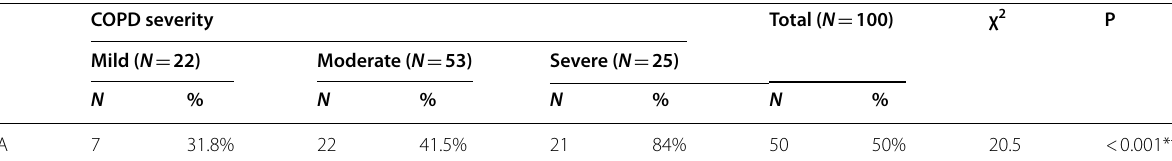
Table 3 OSA prevalence in COPD